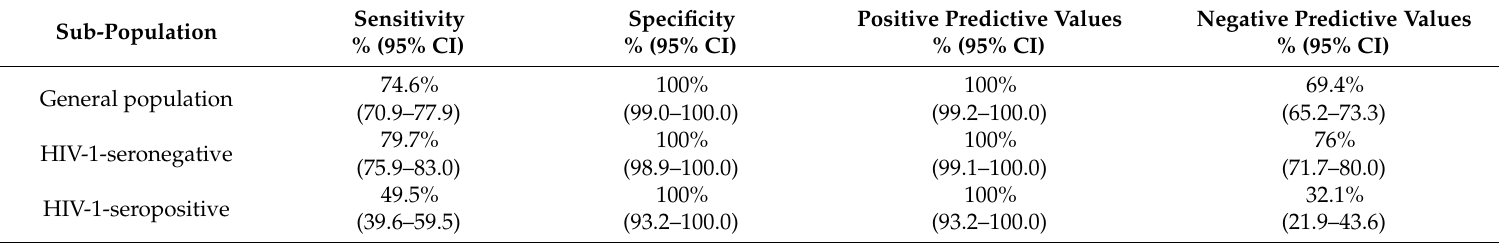
Table 5. Sensitivity and specificity of the Kato Katz technique using a combined gold standard in a sub-population of study